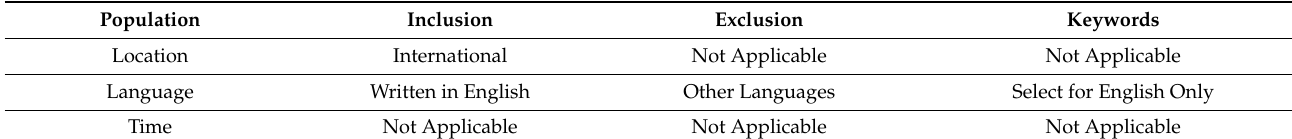
Table 1. Summary of inclusion/exclusion criteria and keywords.